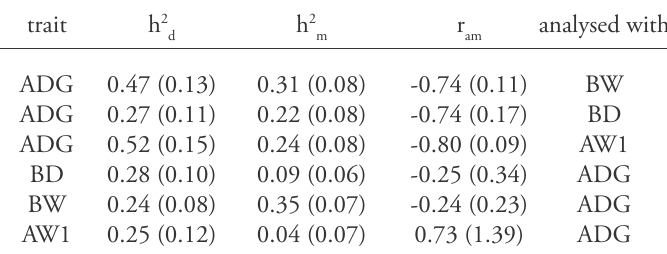
Table 5. The estimates of direct (h 2 ties and direct-maternal correlations (r birth date (BD), birth weight (BW) and calf autumn weight (AW1) in the Kutuharju reindeer herd in 1987-2011.